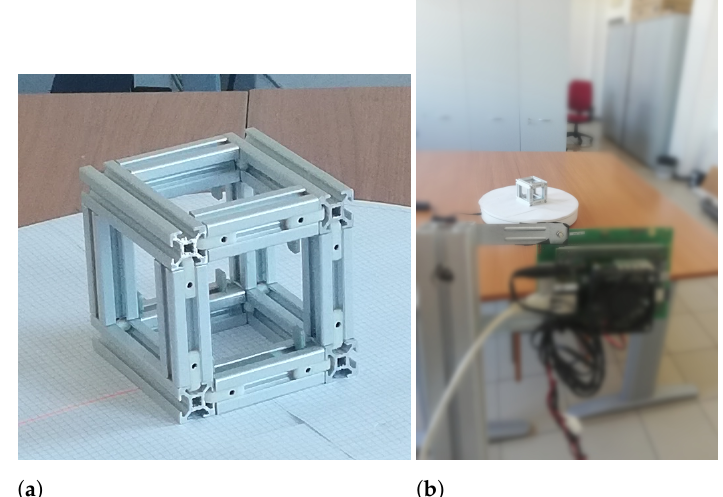
Figure 5. First object. ( a ) Photo of the object used as target during experiments; ( b ) photo of the acquisition set-up of the experiment.